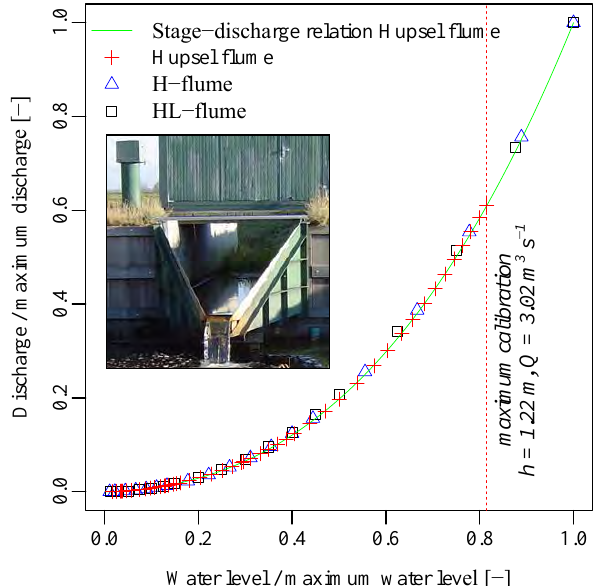
Fig. 3. Stage-discharge relationships for different types of